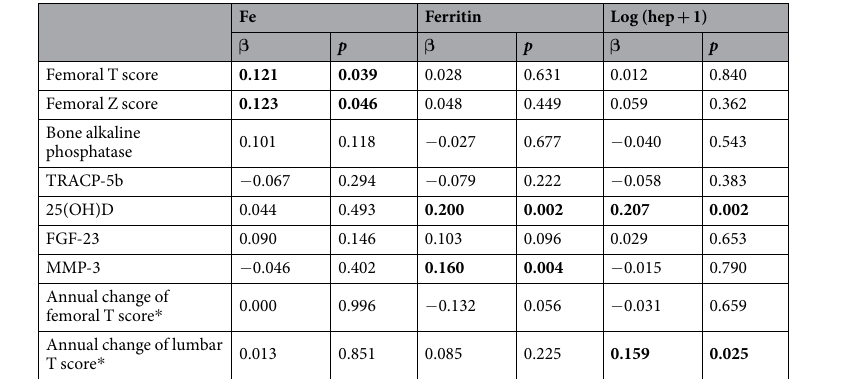
Table 4. Relationships between serum iron, ferritin, and hepcidin levels and osteoporosis-related factors analyzed by multiple regression. Multiple regression models were adjusted for age, sex, BMI, eGFR, CRP, PSL use, bDMARD use, anti-resorption drug use, teriparatide use, and iron agent use. TRACP-5b, tartrate-resistant acid phosphatase-5b; 25(OH)D, 25-hydroxy vitamin D; FGF23, fibroblast growth factor 23; MMP-3, matrix metalloprotease 3. * Annual change of T score was evaluated in 231 patients and the mean observational period was 2.0 ± 0.33 years